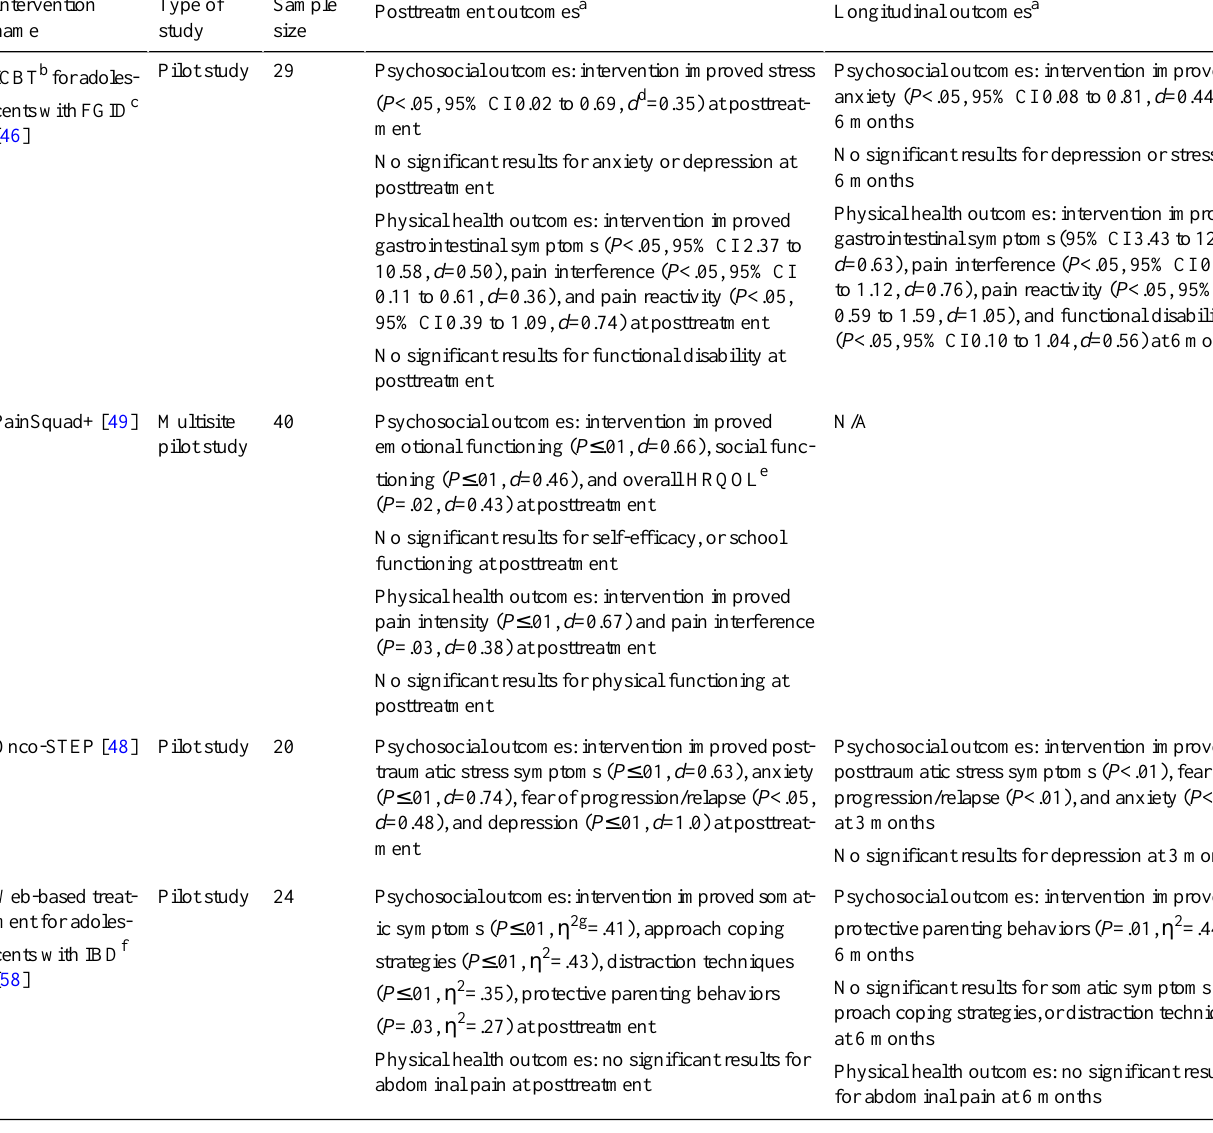
Table 3. Original research publications with quantitative outcomes: nonrandomized controlled trials. name